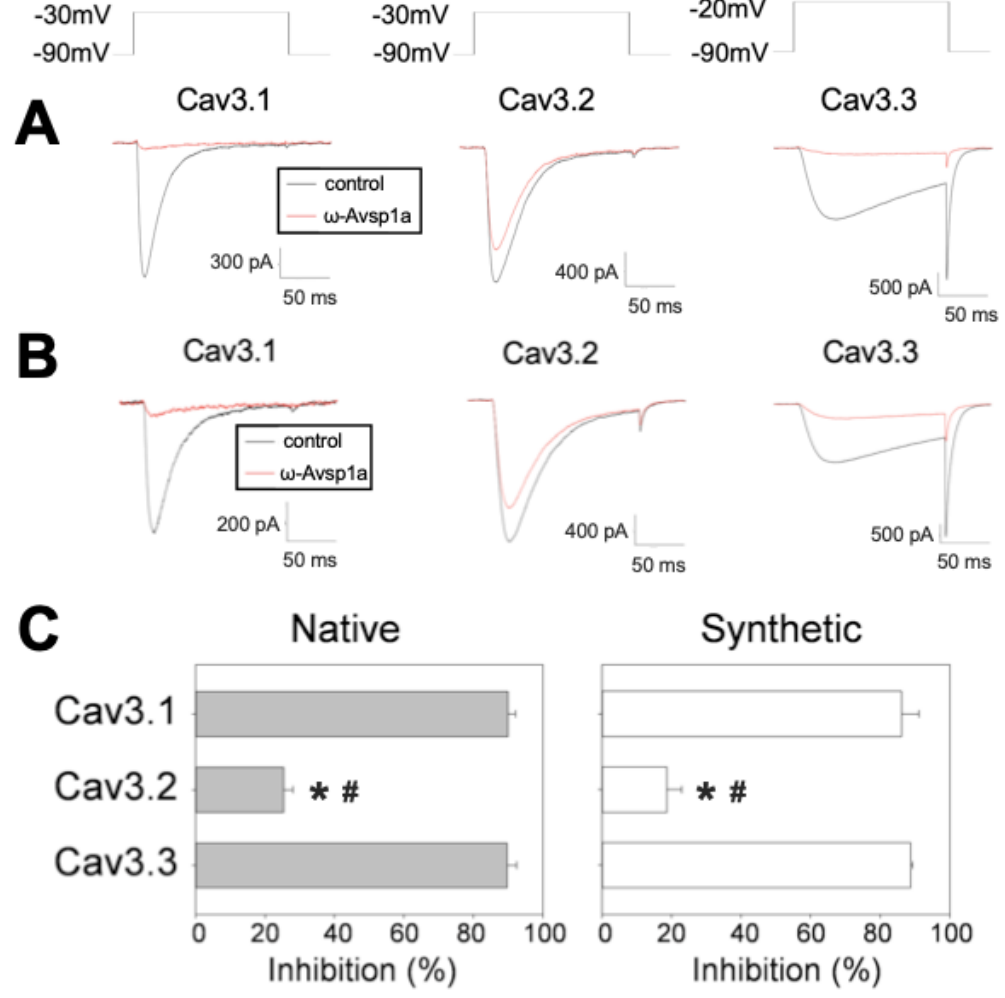
Figure 4. Comparison of the effect of native and synthetic ω -Avsp1a on Ca V 3.1, Ca V 3.2, or Ca V 3.3 expressed in HEK-293 cells. Plasmids of Cav3.1, Cav3.2 or Cav3.3 were separately transfected into HEK-293 cells. ( A ) ω -Avsp1a purified from venom potently inhibited Ca V 3.1 and Ca V 3.3 but it was only a weak inhibitor of Ca V 3.2. The native toxin concentration was 4.1 µ M. n = 5 for Ca V 3.1 and Ca V 3.2 and n = 3 for Ca V 3.3. The voltage-clamp protocols to elicit Cav3.1, Cav3.2 or Cav3.3 are indicated above ( B ) synthetic ω -Avsp1a replicates the inhibitory effects of the native toxin, with potent inhibition of Ca V 3.1 and Ca V 3.3 and weak inhibition of Ca V 3.2. The concentration of synthetic ω -Avsp1a was 10 μM. n = 9 for Ca V 3.1 and Ca V 3.3, and n = 6 for Ca V 3.2. ( C ) Quantification of the inhibitory effects of native and synthetic ω -Avsp1a on human Ca V 3 channels. * p < 0.001 vs. Cav3.1 and # p < 0.001 vs. Cav3.3 according to one-way ANOVA with Tukey ’ s post hoc test.